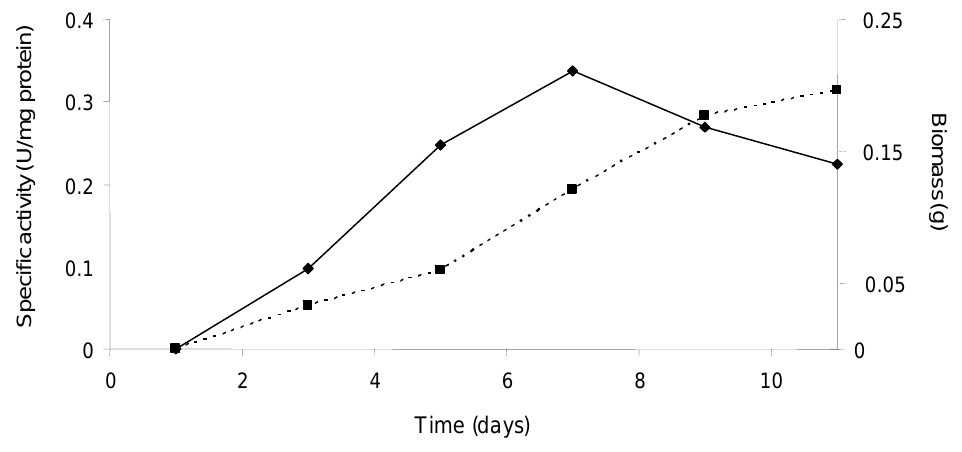
Figure 1. Relationship between biomass (dotted line) and specific activity (continuous line) of the enzyme laccase produced by Trametes sp